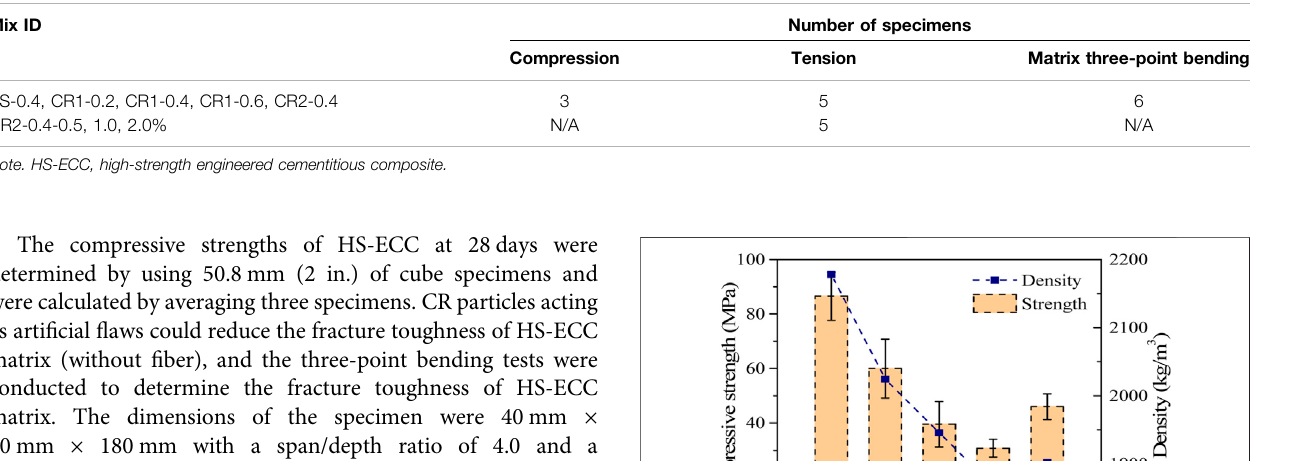
TABLE 2 | Testing scheme of